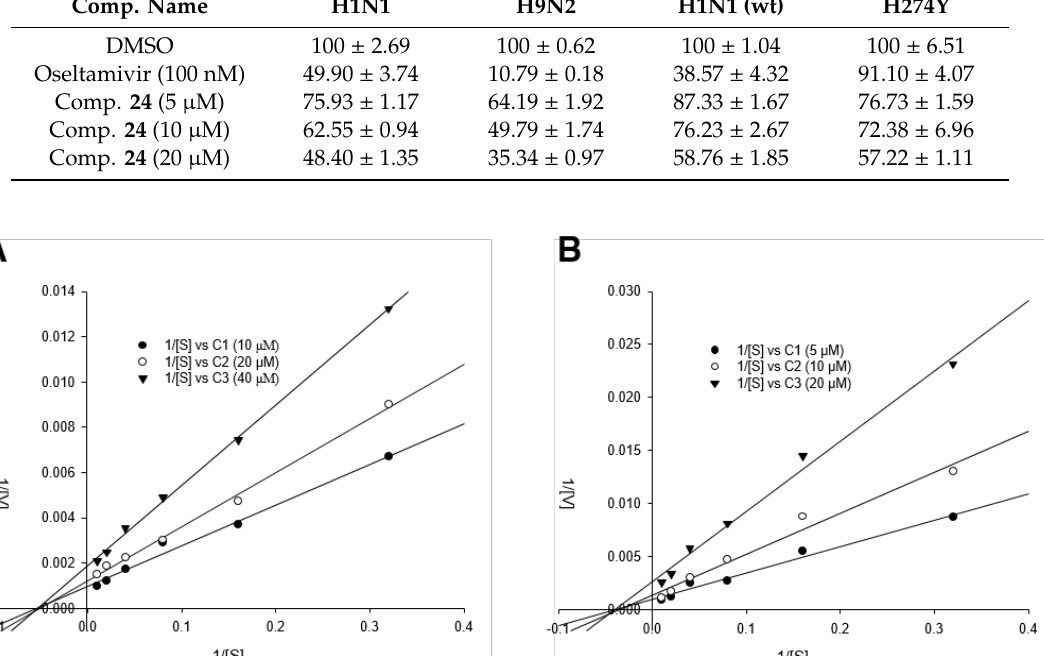
Figure 5. Inhibition mode of compound 24 on the NA H1N1/PR/8/34 and H9N2 A/Chicken/Korea/O1310/2001 enzymes. Lineweaver – Burk plots for the inhibition of compound 24 ( A ) at three concentrations (C1 = 10 µ M, C2 = 20 µ M, and C3 = 40 µ M) on NA from the H1N1